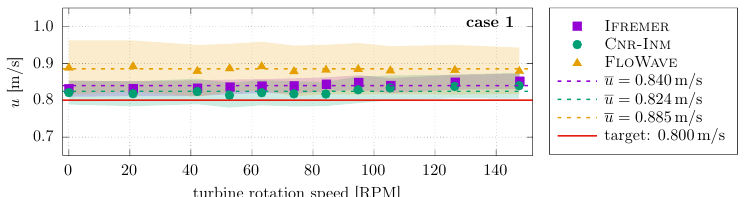
Figure 7. Time average (markers) and standard deviation (shading) of the ADV stream-wise velocity u versus turbine rotational speed for current-only case 1 at all facilities. Dashed lines are the average of u for case 1 at all rotational speed settings per facility; the red line is the target value of 0.8 m/s.